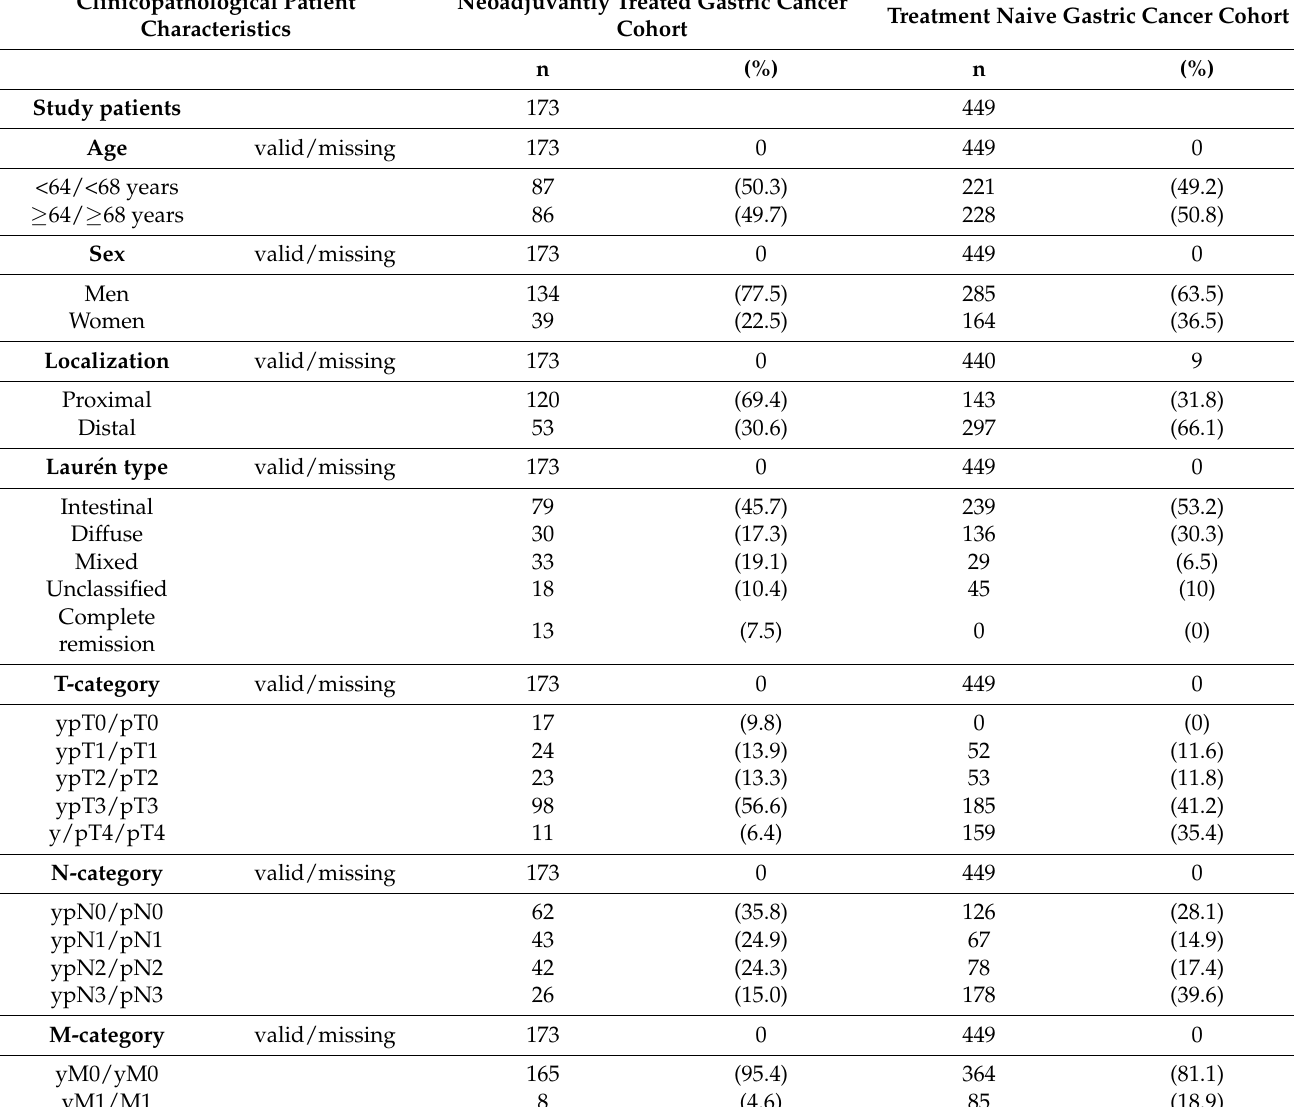
Table 1. Clinicopathological patient characteristics of the neoadjuvantly treated gastric cancer cohort and the treatment naïve cohort